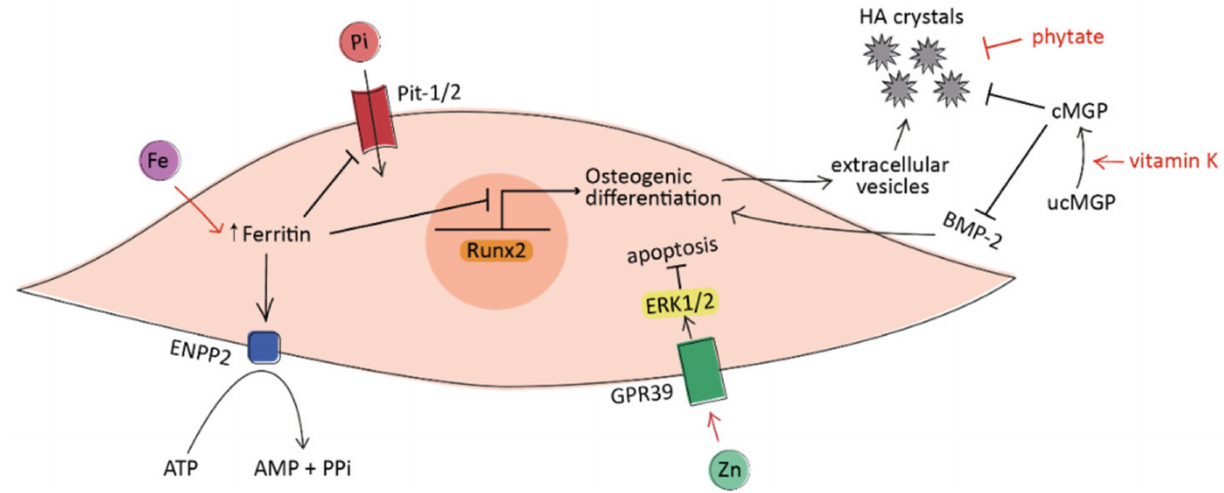
Figure 2. A simplified schematic representation of the processes under investigation leading to the osteogenic differentiation of VICs in vascular calcification. Iron (Fe) acts at the intracellular level via ferritin, which prevents phosphate uptake and inhibits VICs osteogenic differentiation. Moreover, ferritin promotes the production of anti-calcific pyrophosphate (PPi) from ATP by activating the enzyme ENPP2. Zinc (Zn) induces VICs apoptosis through the activation of the GPR39-ERK1/2 signaling pathway. Vitamin K promotes the carboxylation and activation of matrix Gla protein (MGP), which avoids the formation of hydroxyapatite (HA) crystals and prevents the pro-calcific action of BMP-2. Phytate acts as crystallization inhibitor by binding to HA crystals. The regular arrow denotes “activation”, and the T-shaped arrow stands for